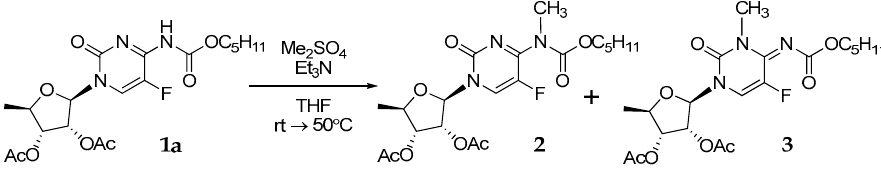
Figure 4. The isomeric N -methyl substituted acetyl protected capecitabine 2 and 3 .